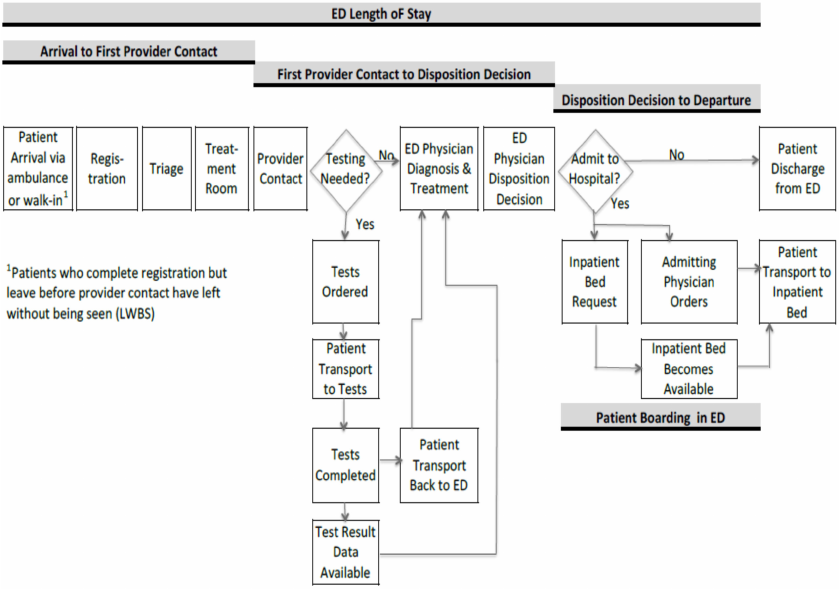
Figure 2. ED patient